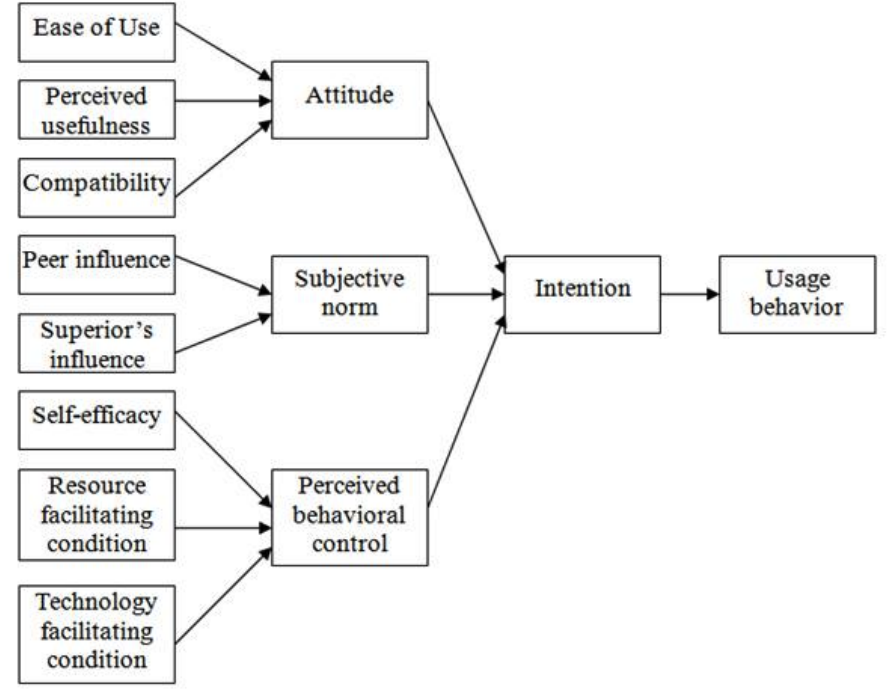
Figure 4. Decomposed theory of planned